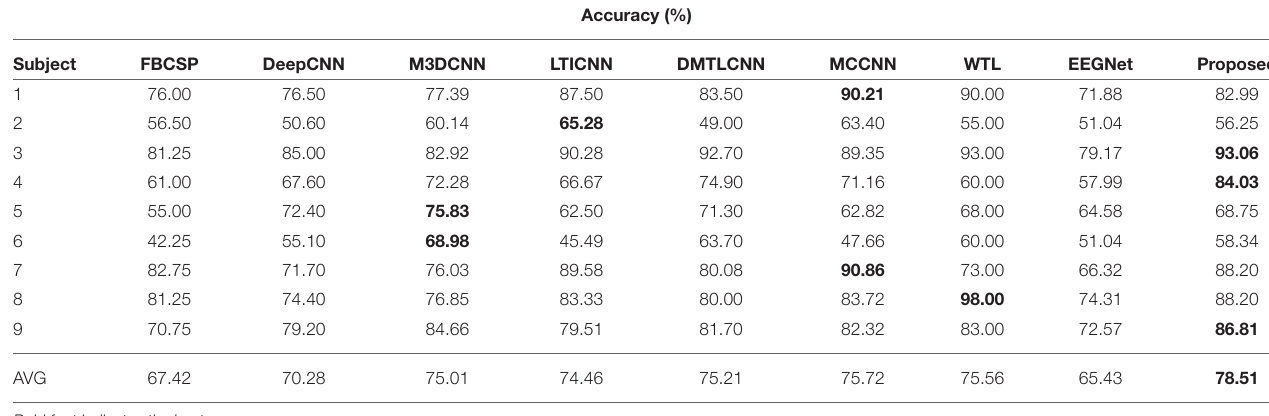
Bold font indicates the best scores.